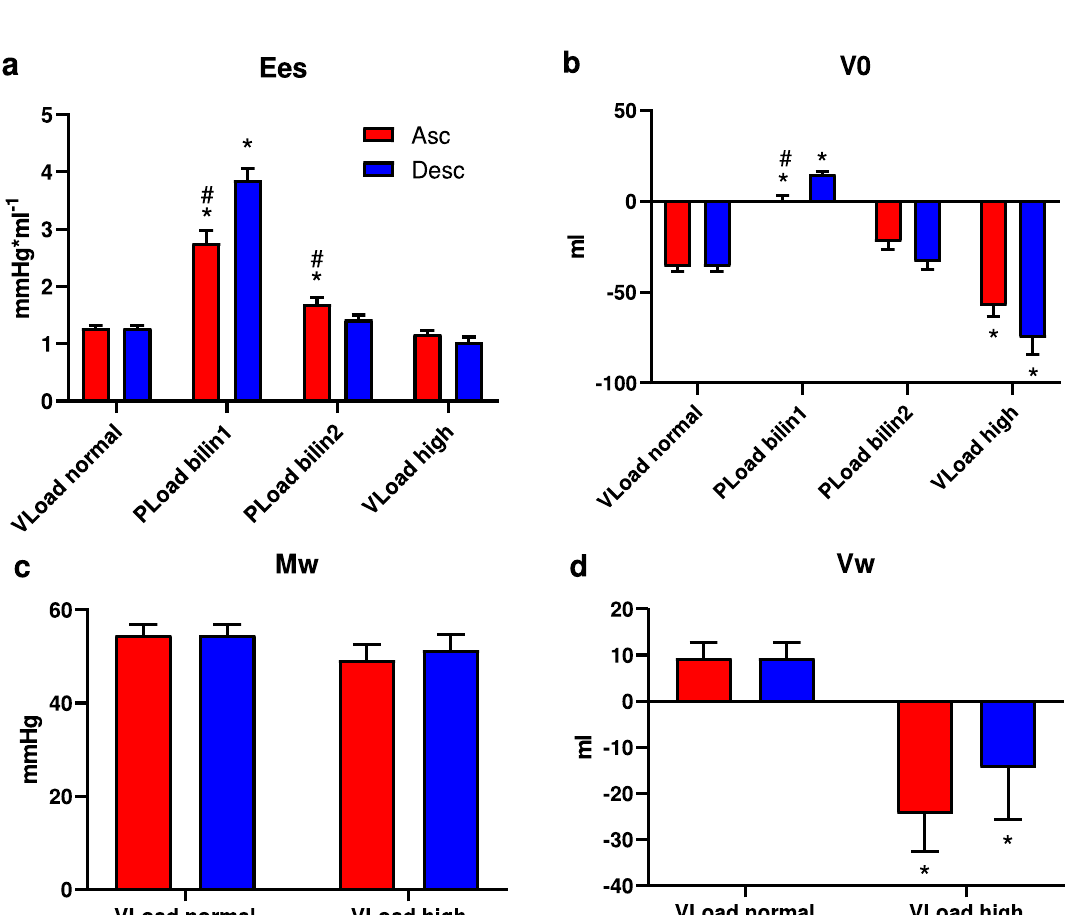
Figure 4. Slope (Ees) and x-axis intercept (V0) of the ESPVR ( a , b ) and slope (Mw) and x-axis intercept (Vw) of the PRSW ( c , d ) derived from a preload reduction (VLoad normal), the two phases of an increase in afterload (PLoad bilin1 and PLoad bilin2) and a preload reduction of an augmented afterload level (PLoad high). The increases in afterload were achieved by either occlusion of the ascending aorta (ASC) or inflation of a balloon catheter in the descending aorta (DESC). (Mean values ± SD; *p < 0.05 vs. VLoad normal, # p < 0.05 vs.